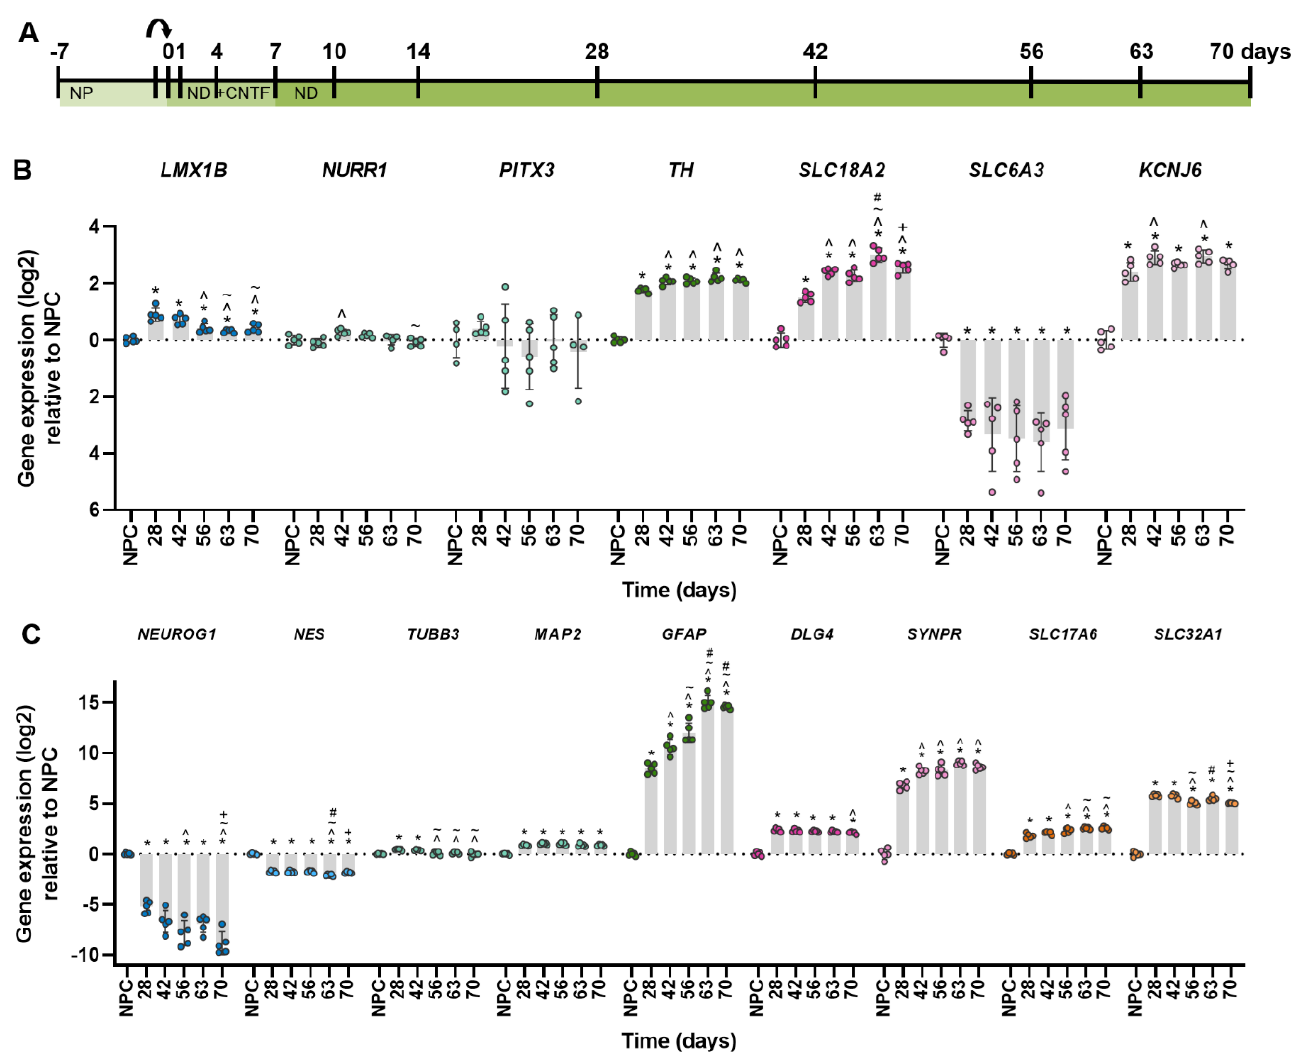
Figure 1. Gene expression over the course of neuronal-glial differentiation. ( A ) Timeline of the culture protocol and time points of sampling. Arrow indicates replating to a new culture plate. ( B ) Gene expression over time of a selection of dopaminergic markers for cell types relative to the neural progenitor cell (NPC) culture, ordered by expected timing of expression: early markers for differen- tiation of dopaminergic progenitor cells ( LMX1B ), differentiation of dopaminergic neurons ( NURR1 , PITX3 ), a catecholaminergic neuron marker ( TH ) and proteins that can transport dopa- mine ( SLC618A2 , SLC6A3 ) or are involved in dopaminergic neurotransmission ( KCNJ6 ). ( C ) Gene expression over time of a selection of markers for cell types relative to the NPC culture: NPC ( NEU- ROG1 , NES ), neurons ( TUBB3 , MAP2 ), astrocytes ( GFAP ), synapses ( SYNPR , DLG4 ), excitatory ( SLC17A6 ) and inhibitory ( SLC32A1 ) neurotransmitter vesicles. NP: neural progenitor medium, ND: neural differentiation medium CNTF: Ciliary neurotrophic factor. Significance (adjusted p - value ≤ 0.05) is indicated relative to *: NPC, ^: 28 days, ~: 42 days, #: 56 days, +: 63 days. Full statistics can be found in Supplementary Table S1.